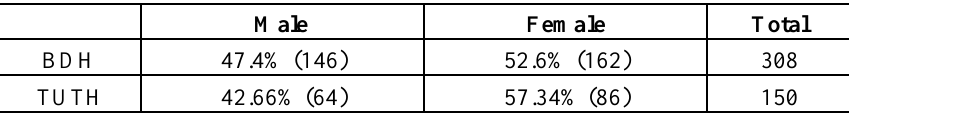
Table I : Total number of poisoning cases and their Sex distribution